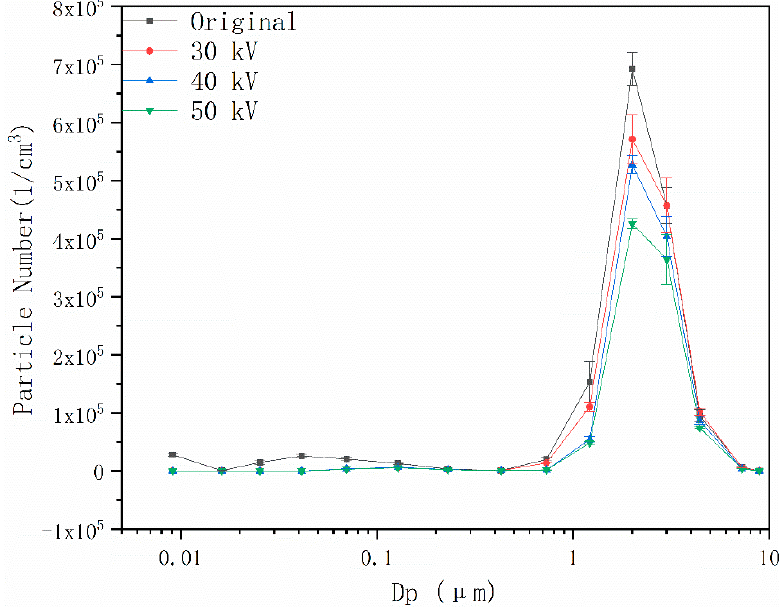
Figure 13. Number concentration of 2- μ m particles at different voltages.